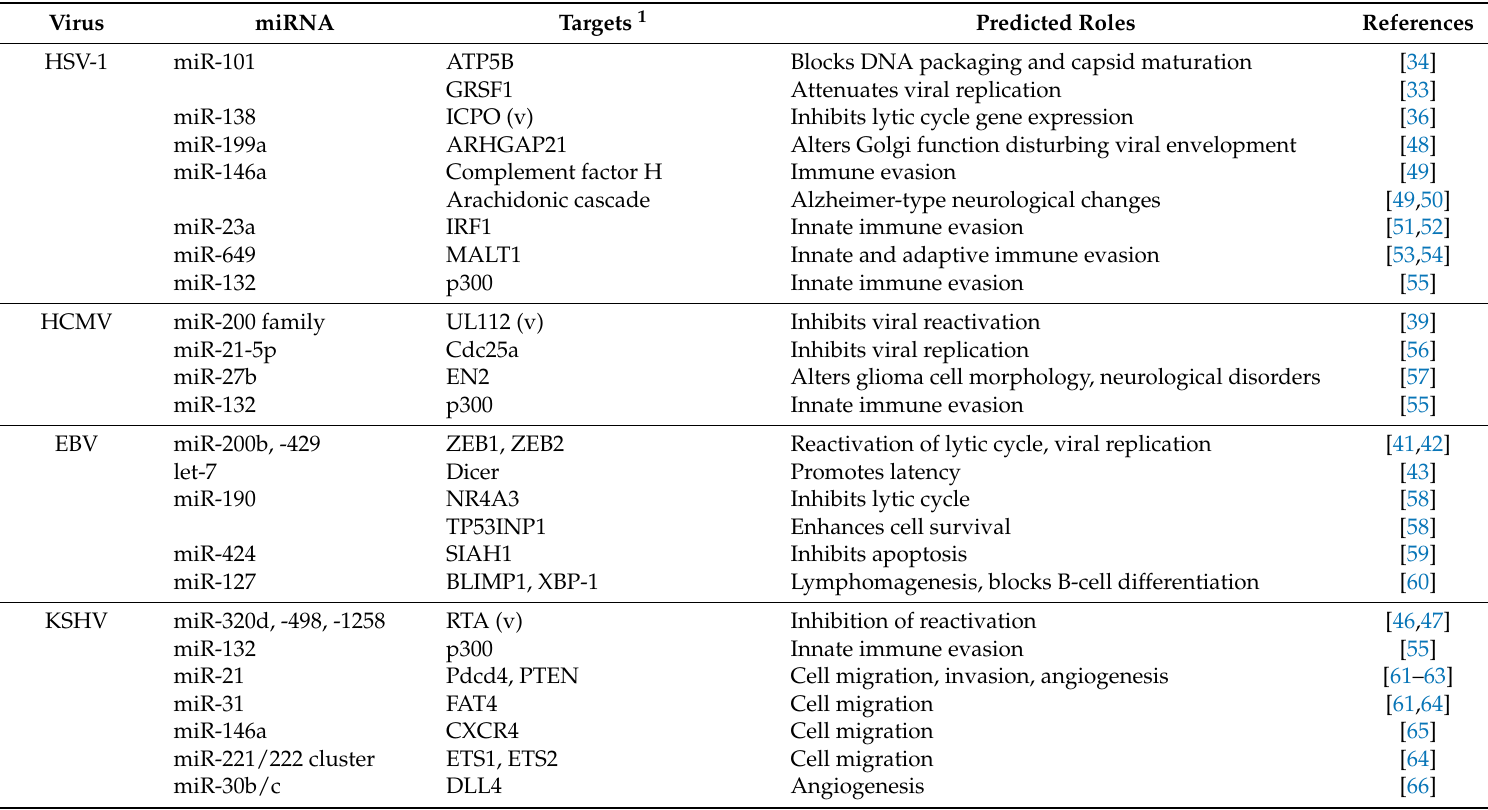
Table 1. Cellular miRNAs with putative roles in herpesvirus